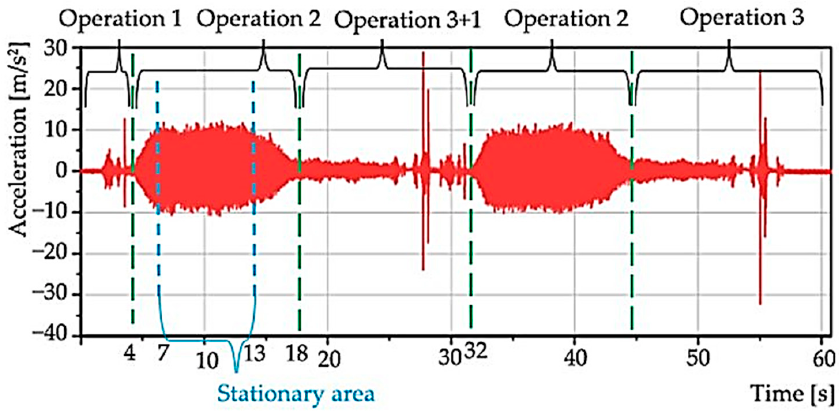
Figure 7. Acceleration values from one whole mode measurement.